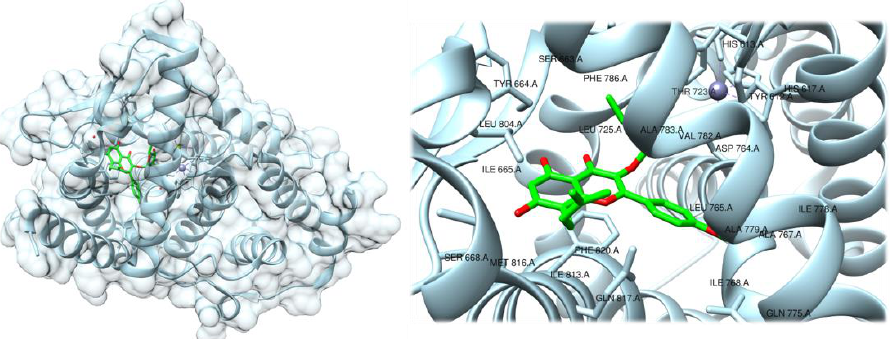
Figure 3. 3D structure of PDE5 in complex with icarisid II, a natural inhibitor from Epimedium brevi- cornium (PDB ID: 2H44). In the artwork, the residues interacting with the ligand (<5 Å ) have been labeled.